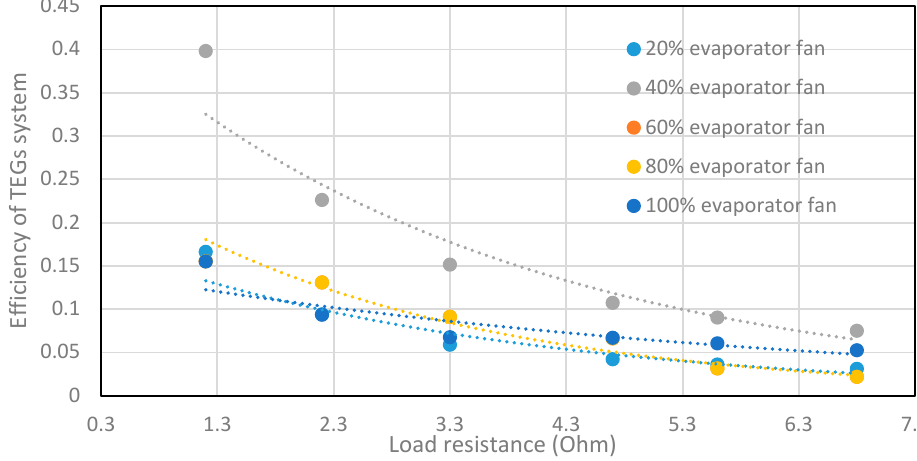
Figure 12. Variation of TEGs efficiency with load resistance at different values of evaporator load.